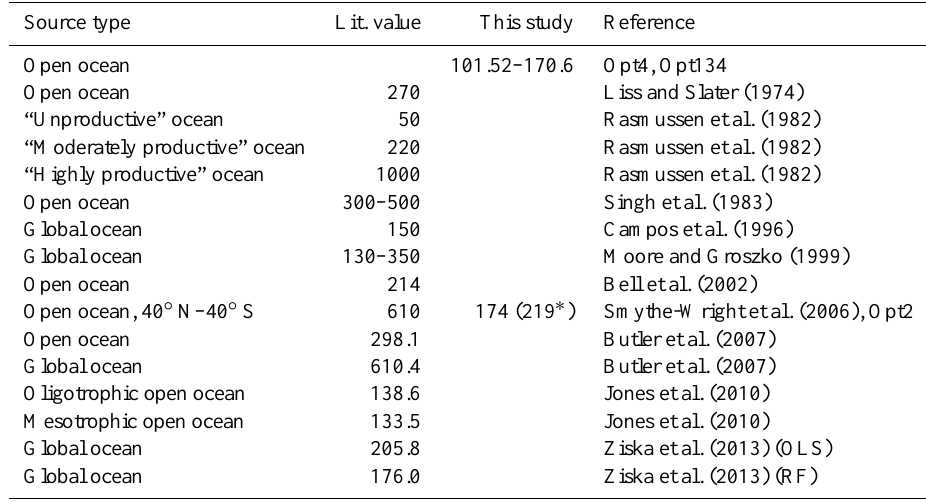
Figure 10. Experiment closest to the observed concentration at the sea surface, when considering only single source experiments (a) , and only mixed source experiments (b) . Table 4. Global annual methyl iodide emissions (Ggyr − 1 ) from the